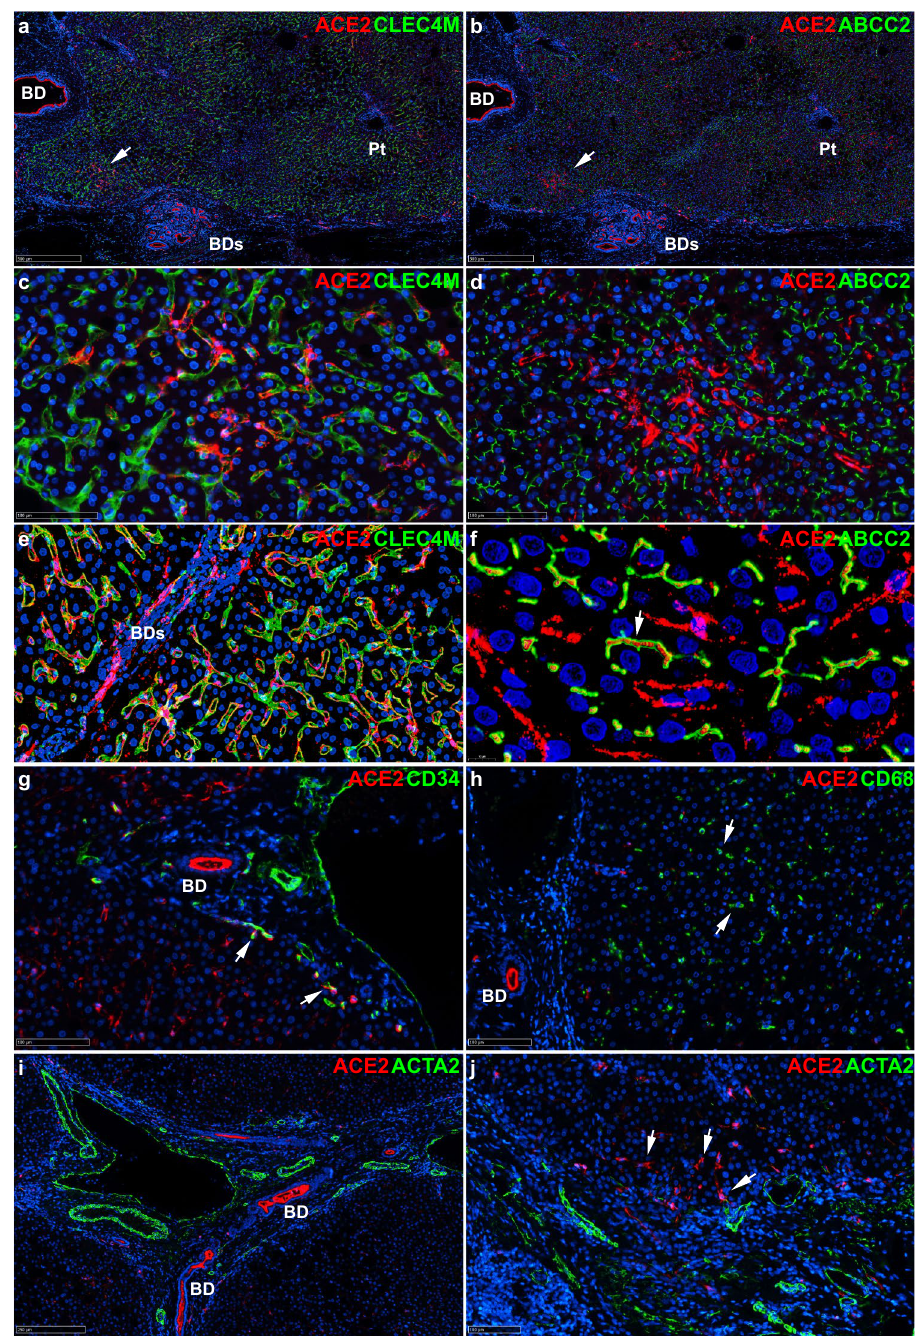
Figure 3. ACE2 is detected in sinusoidal endothelial cells, bile ducts and capillaries of the periportal plexus in non-tumor livers. Co-immunostaining for ACE2 and the indicated markers in three non-tumor livers from patients undergoing resection of colon cancer metastasis. Representative images are shown. ACE2 appears in red by immunofluorescence, other markers in green and nuclei in blue (DAPI staining). ( a ), ( b ) Low power views (X5 magnification) show ACE2 in a bile duct ( BD ) and in a zone with mild inflammatory infiltration ( arrow ) and dystrophic bile ducts ( BDs ). The sinusoidal endothelial cell marker CLEC4M (a.k.a. DC-SIGNR) and the bile canaliculi marker ABCC2 (a.k.a. MRP2) show lobular staining at this magnification. Pt, portal tract. ( c ), ( d ) At X30 magnification, ACE is detected in sinusoidal endothelial cells, which can be identified by comparing CLEC4M ( c ) and ABCC2 ( d ) staining. Digital images were acquired with a microscope scanner and a X40 objective and exported at the indicated magnifications (Nanozoomer, Hamamatsu Photonics). ( e ), ( f ) Confocal scans of whole tissue sections as Z-stacks of 4 X 500 nm focusing steps at X40 ( e ) and X143 ( f ). ACE2 is detected in CLEC4M-positive sinusoidal endothelial cells ( e ) and within ABCC2-positive bile canaliculi ( f ). ACE2-positive bile ducts ( BDs ) are seen in ( e ). ( g ) At 28X magnification, ACE2 is sparsely detected in CD34-positive endothelial cells of the periportal vascular plexus ( arrows ) . ( h ) At 24X magnification, no evidence of ACE2 detection in CD68-positive Kupffer cells. ( i ), ( j ) No evidence of ACE2 detection in vascular smooth muscle ( i , 10X magnification) or in ACTA2 (a.k.a alpha smooth muscle actin)-positive cells within portal tract stroma ( j , 20X magnification). ACE2-positive cells within the portal tract are ACTA2 negative ( arrows )